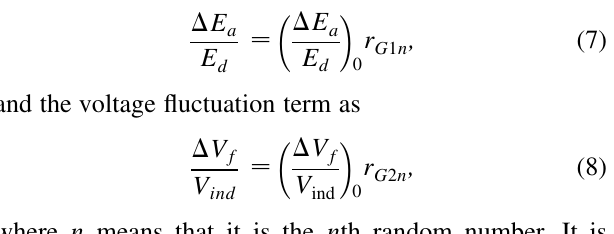
(cid:3) (cid:1) V > V , (a) for E < E f ind limit